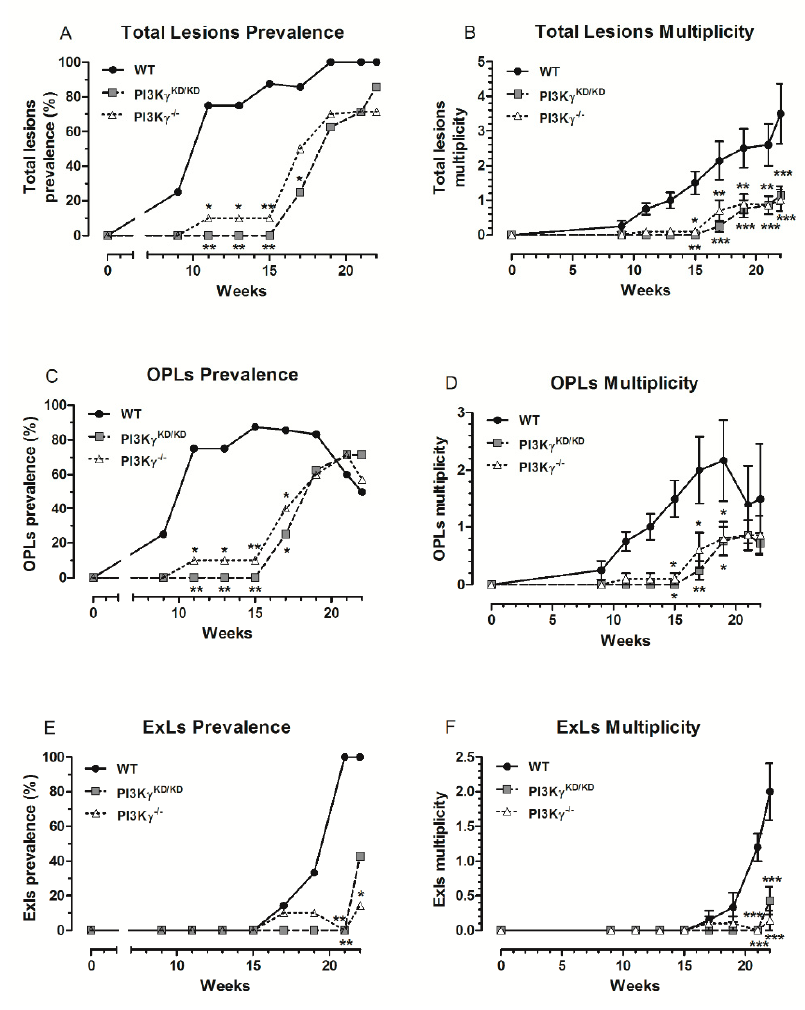
Figure 1. ( A ) Total lesion prevalence, ( B ) total lesion multiplicity, ( C ) OPL prevalence, ( D ) OPL multiplicity, ( E ) ExL prevalence, and ( F ) ExL multiplicity of WT, PI3K γ KD/KD and PI3K γ − / − mice treated with 4NQO. Values represent mean ± SEM. PI3K γ KD/KD /PI3K γ − / − vs. WT: * p < 0.05, ** p < 0.01 and *** p < 0.001.